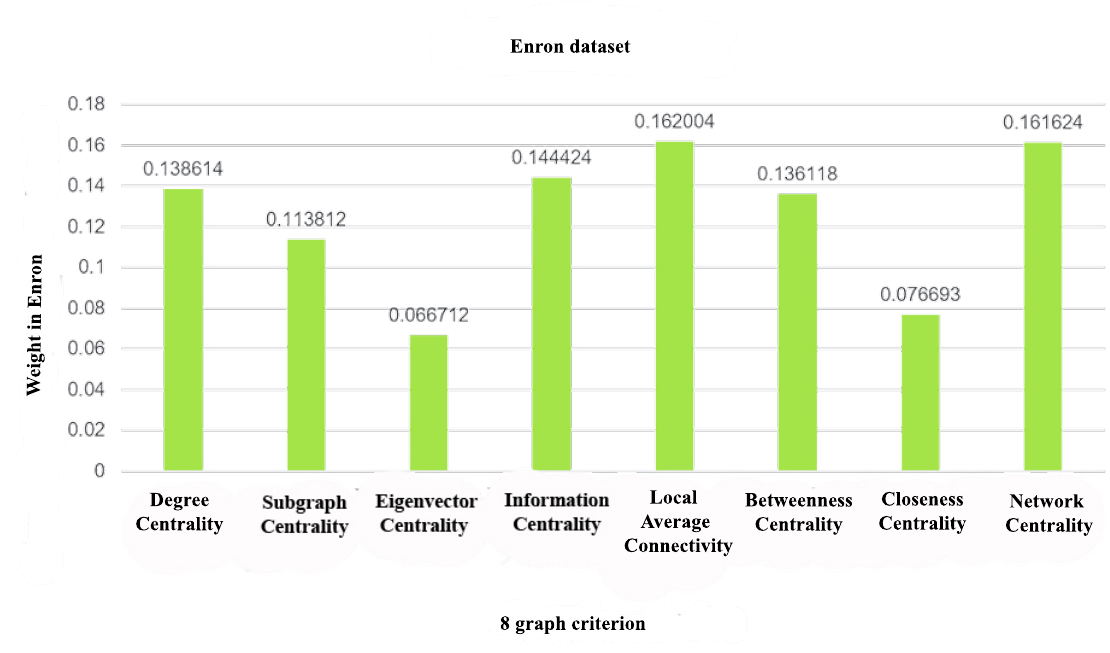
Figure 5. The average weighting of each criterion in the calculation of the important-score criterion by performing a 10-fold cross-validation on the DINGA system in the Enron dataset.